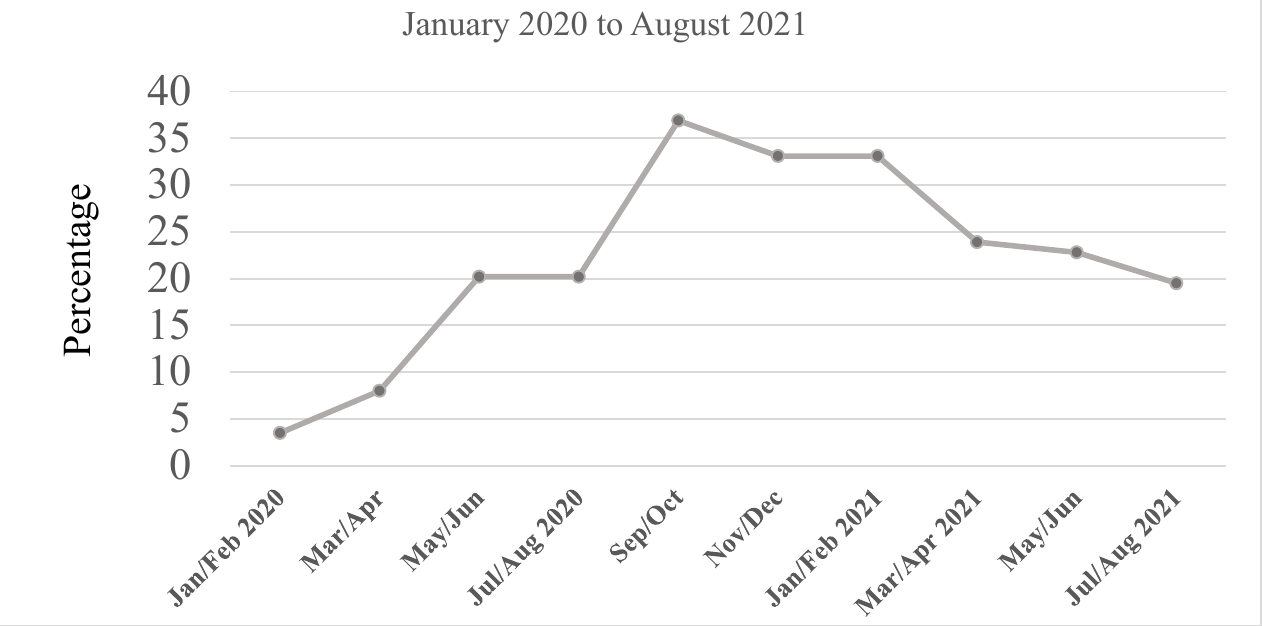
Figure 1. Food Insecurity Trend among NeighborhoodHELP Households.